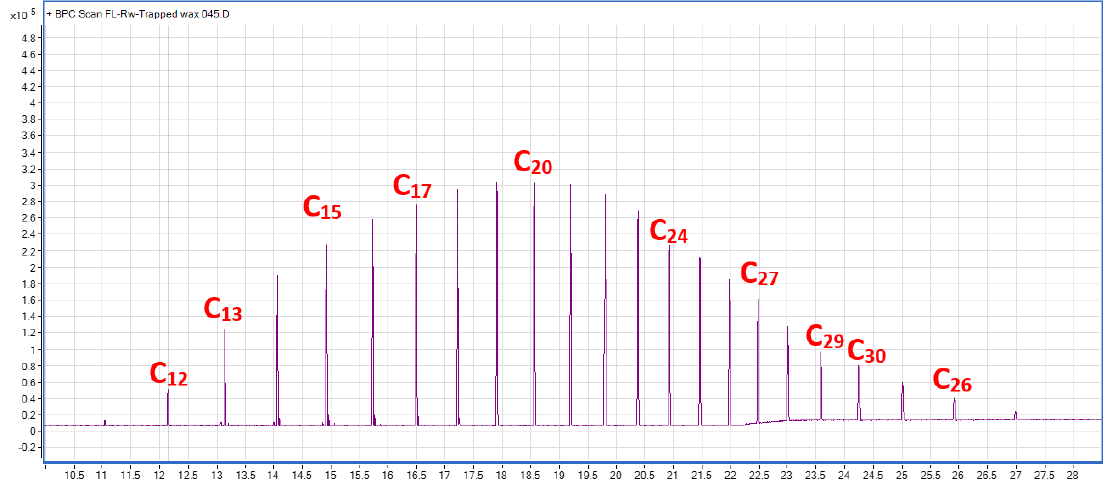
Figure A8. Trapped wax chromatogram analysis for R3.